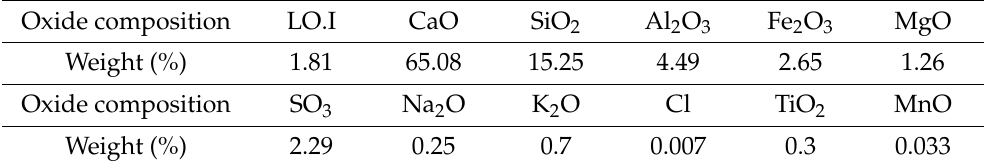
Table 2. Chemical composition of Portland cement.